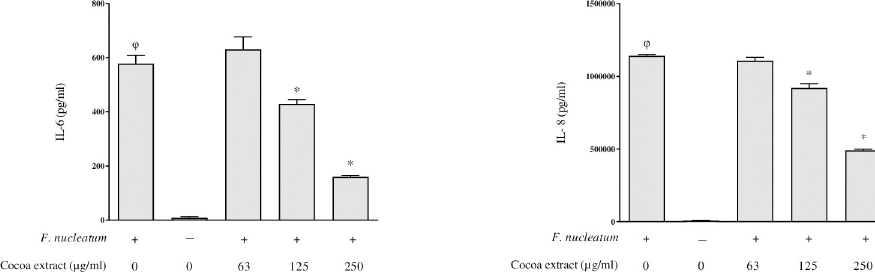
Fig 3. Effect of the cocoa extract on the secretion of IL-6 and IL-8 by oral epithelial cells (GMSM-K cell line) stimulated with F . nucleatum (MOI = 100). φ , significant increase compared to the control (no F . nucleatum stimulation). � , significant inhibition ( p < 0.01) compared to the control (no cocoa extract).